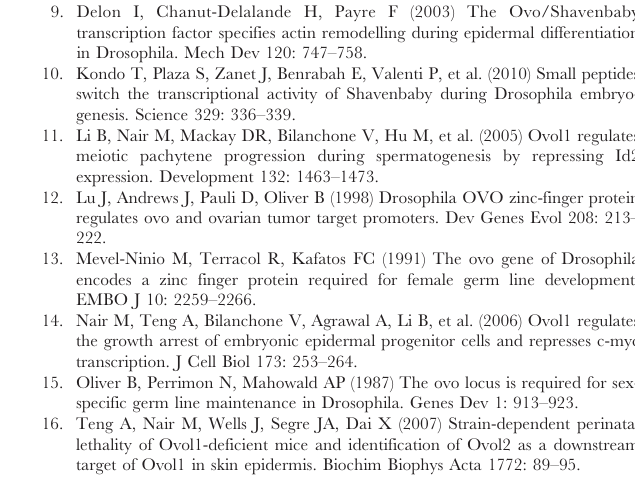
(PDF) Figure S2 Similarities and differences among Drosoph- ila OVOA-D and mouse OVOL1-OVOL3 using protein sequence alignment. Zinc finger motif is a highly conserved region (red shading). The presence of multiple stretches of the same amino acids are visible in this alignment in the N-terminal regions. (PDF) Figure S3 A highly conserved motif is found immedi- ately after the fourth C2H2 motif present in the majority of OVOL proteins from metazoan origin. We generated this sequence logo using WebLogo 3.0 [81]. (PNG) File S1 Protein sequence alignment of full length OVOL. We generated this alignment using MUSCLE [43,44] at default parameters. This alignment was utilized for the reconstruction of the Bayesian phylogenetic tree ( Figure 7A) . File S2 Protein sequence alignment of selected regions of OVOL. We generated this alignment using MUSCLE [43,44] at default parameters. This alignment was used for the re- construction of the Bayesian phylogenetic tree ( Figure 7B)